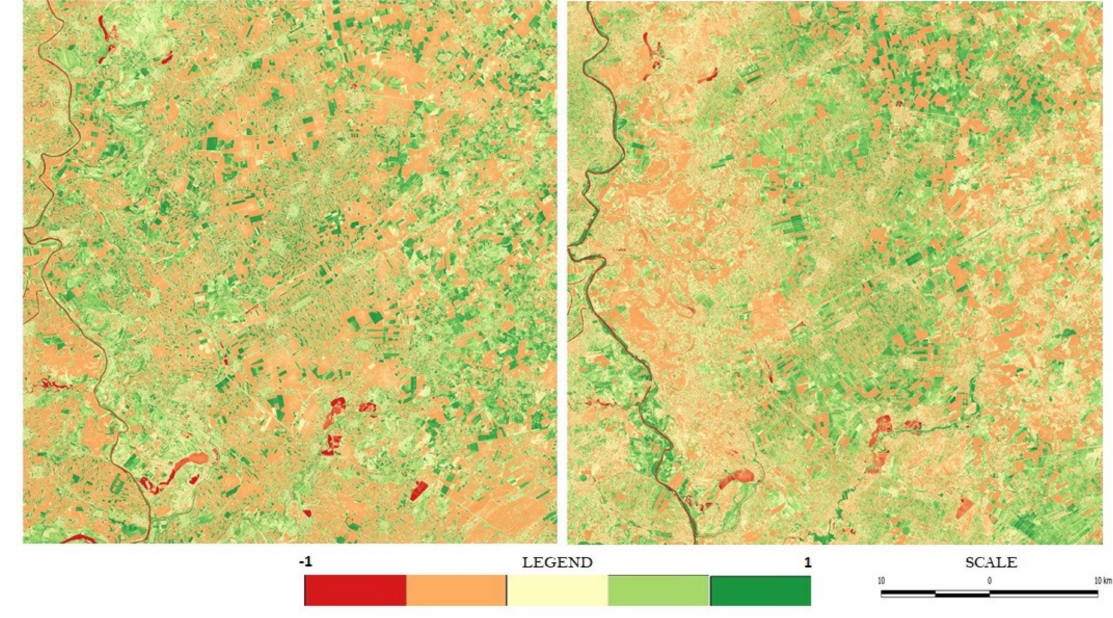
Figure 2. Sentinel-2 derived NDVI before and during the